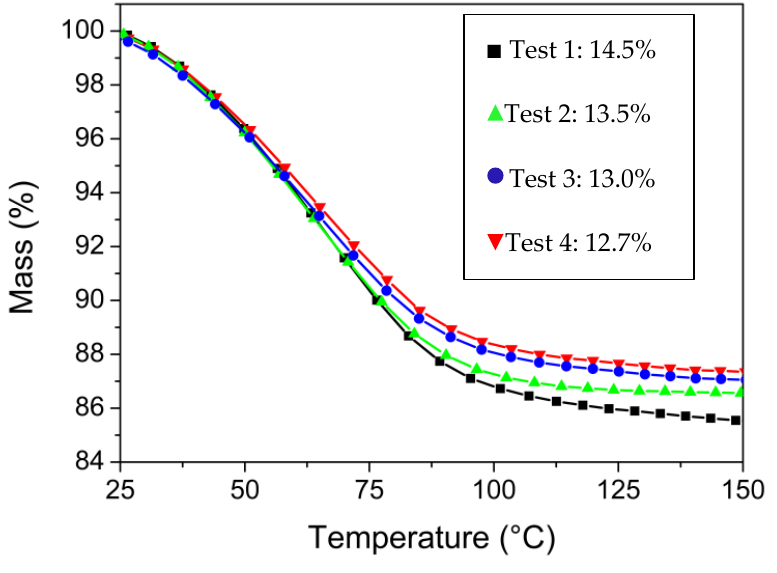
Figure 8. Cyclic TGA test for microfibres Mf-5.